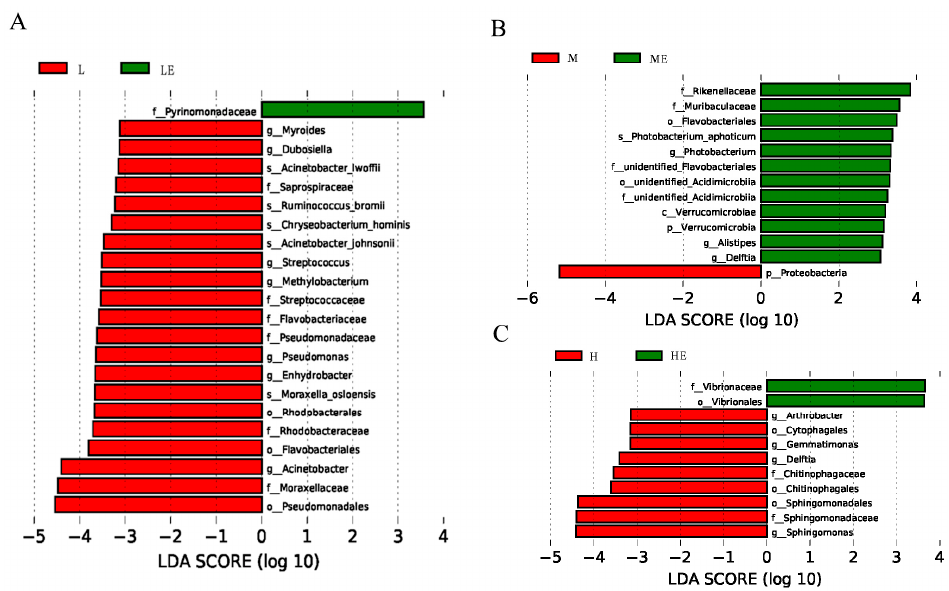
Figure 6. Linear discriminant analysis effect size (Lef Se) results revealed differences in intestinal flora between enzyme-free and enzyme groups (Figure 6A = groups L and LE by Lef Se; Figure 6B = groups M and ME by Lef Se; Figure 6C = groups H and HE by Lef Se). LDA score > 3, p < 0.05.